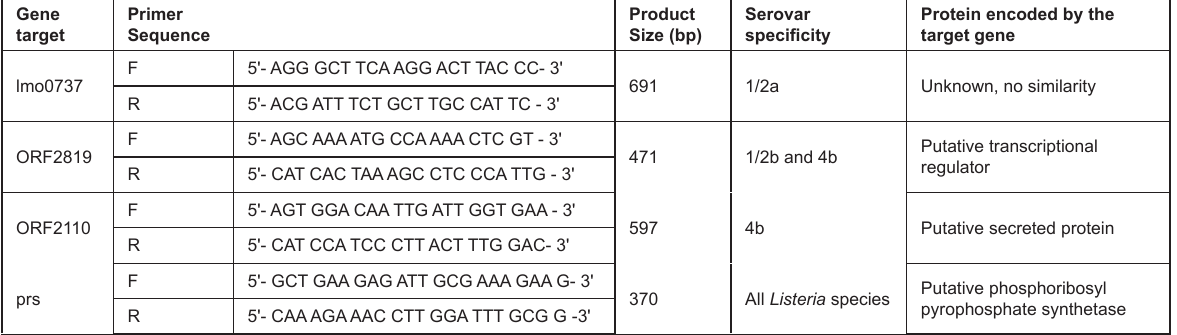
Table 2. Details of primers for amplification of target genes of Listeria monocytogenes employed in serotyping PCR Gene